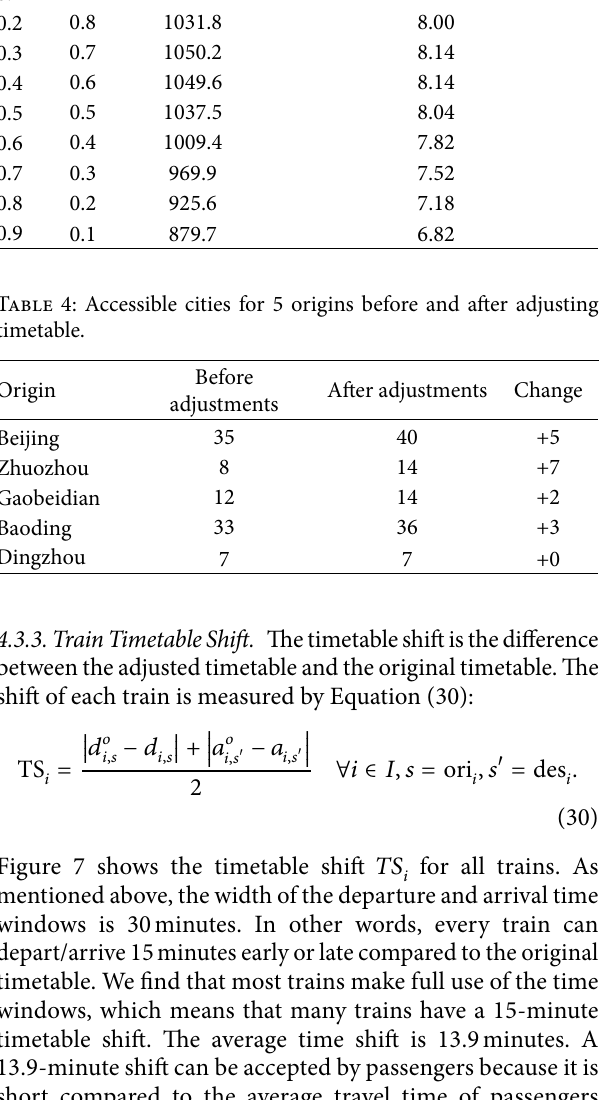
and v values. 1 2